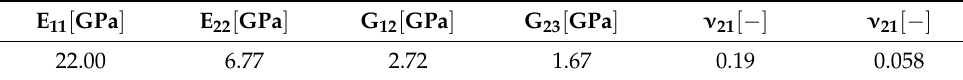
Table 8. The element and material properties of the